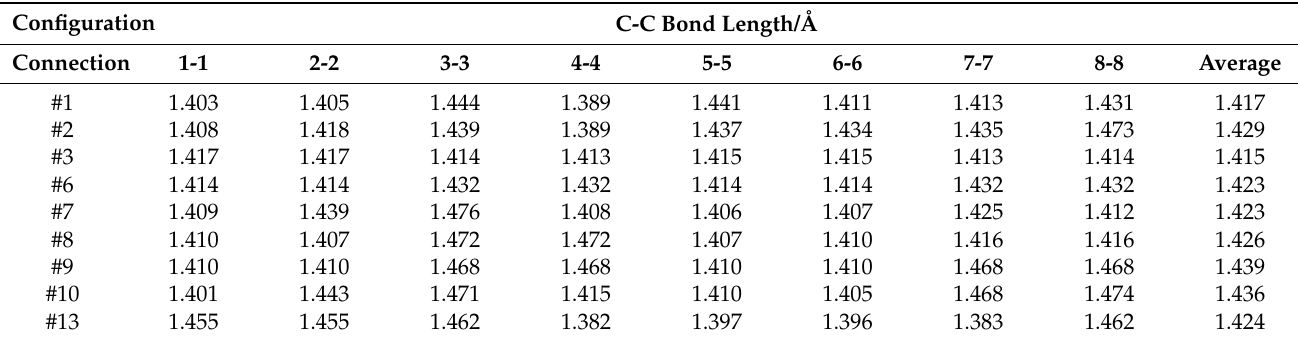
Table 2. The C-C bond length around the connection joints of (8,0)CNT-graphene according to the numbering order in the references